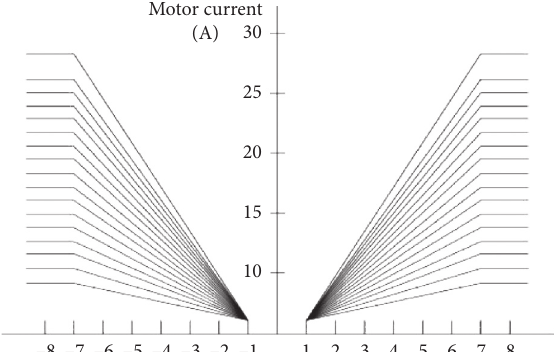
Figure 2: Assist characteristic